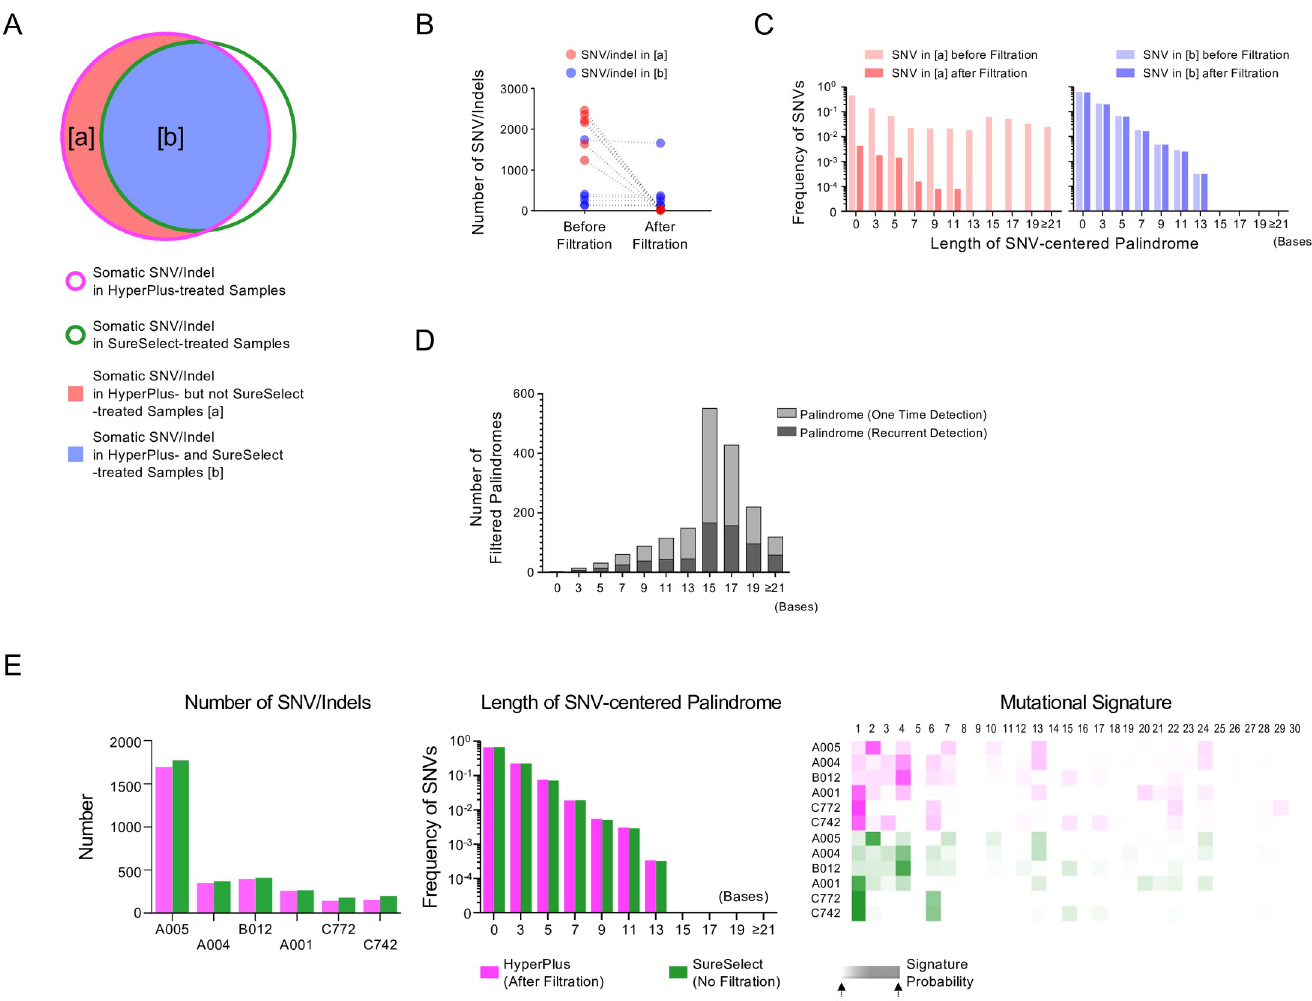
Fig 5. Noise reduction in the six-sample training data. We show changes in the features before and after noise filtration for each sample. (A) Venn diagram of somatic SNVs/indels in the HyperPlus- and SureSelect-treated samples after noise filtering. Magenta and green lines indicate HyperPlus and SureSelect treatments. Region [a] (red) indicates somatic SNVs/indels detected in the HyperPlus- but not the SureSelect-treated samples, whereas region [b] (blue) indicates those shared by both treated samples. The features shown in (A) and (B) were extracted from BAM files from the HyperPlus libraries. (B) Dot plots for changes in the SNV/indel number for each sample after noise reduction. (C) Frequency of SNVs per length of palindrome before and after filtering. Categories [a] and [b] are shown on the left and right panels. Faded and full shading indicate before and after filtration. The frequency of SNVs from all six samples is shown as bar plots per odd length of palindrome, in which a somatic SNV was detected at the center (SCP: SNV-centered palindrome). The number on the x -axis indicates the total length of the palindrome. A length “zero” indicates a sequence that lacks a palindrome. (D) Number of filtered palindromes in a histogram. The number of SCPs was counted per odd-number-length palindrome and shown. Gray and black colors indicate one time and recurrently detected palindromes across the samples, respectively. The reference allele sequence was used to count the SCPs. (E) Comparisons of several features in the sequenced results between the HyperPlus and SureSelect treatments after filtering the HyperPlus artifacts. Note that the noise filter was applied to the HyperPlus data but not to the SureSelect data. Left panel: Bar plots for number of SNVs/indels. Middle panel: Frequency of SNVs per length of palindrome. The frequency of SNVs from all samples ( n = 6) is shown as bar plots per odd length of palindrome, in which a somatic SNV was detected at the center. The number on the x -axis indicates the total length of the palindrome. Note that a length “zero” indicates a sequence that lacks a palindrome. Right panel: Mutational signature heatmap. The heatmap represents the proportions of 30 COSMIC mutational signatures [9] computed from trinucleotide frequencies of nucleotide substitutions in each sample. The number above the heatmap indicates each signature computed according to the definitions in the COSMIC database. Sample IDs are shown on the